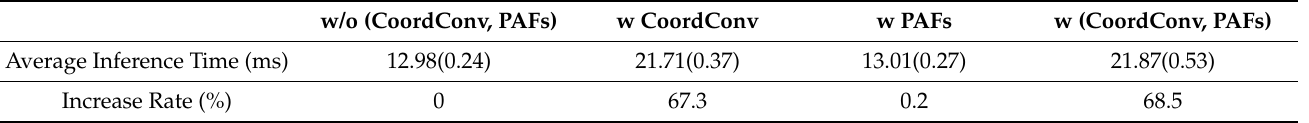
Table 8. Average landmark detection time according to the usage of CoordConv and PAFs. Increase Rate denotes the relative increment in inference time compared to w/o (CoordConv, PAFs).